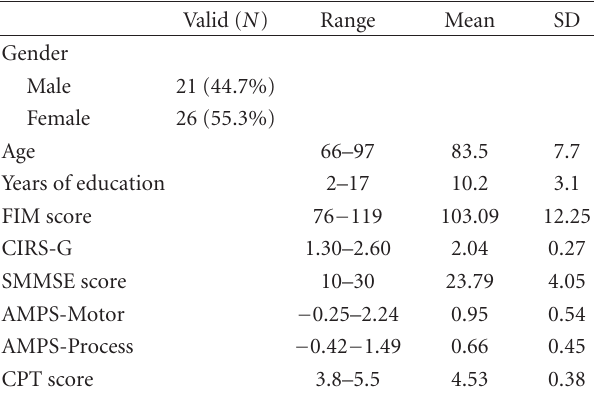
Table 1: Description of